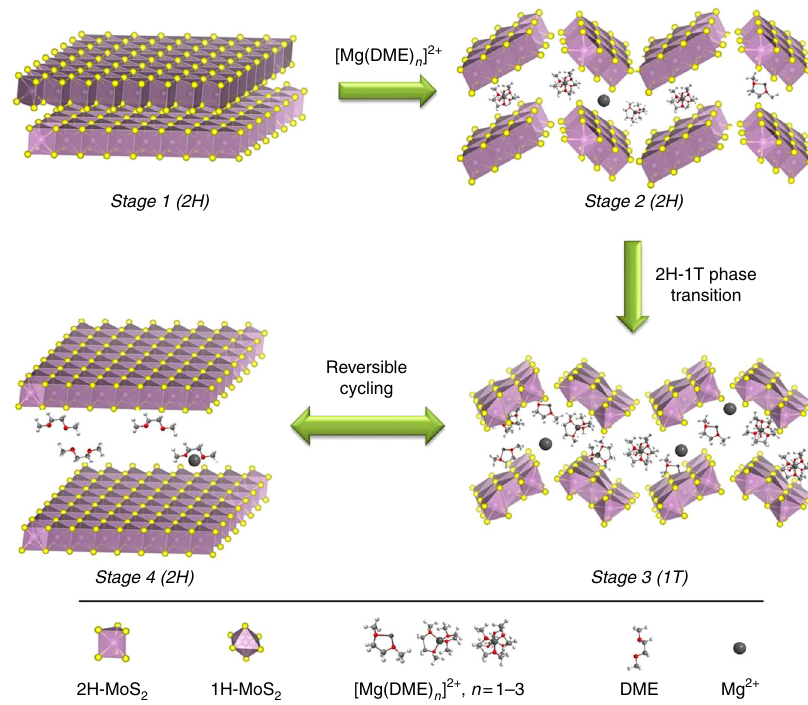
Fig. 7 Schematic illustration of the Mg storage mechanism in MoS 2 structures with MgBOR/DME